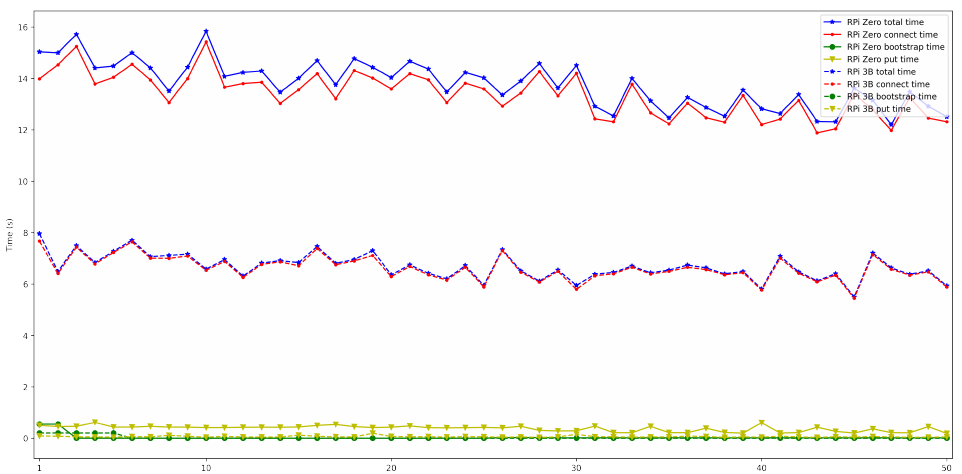
Figure 20. Latency when using Raspberry Pi Zero/3B+ gateways for 600 peers connected to the bootstrap